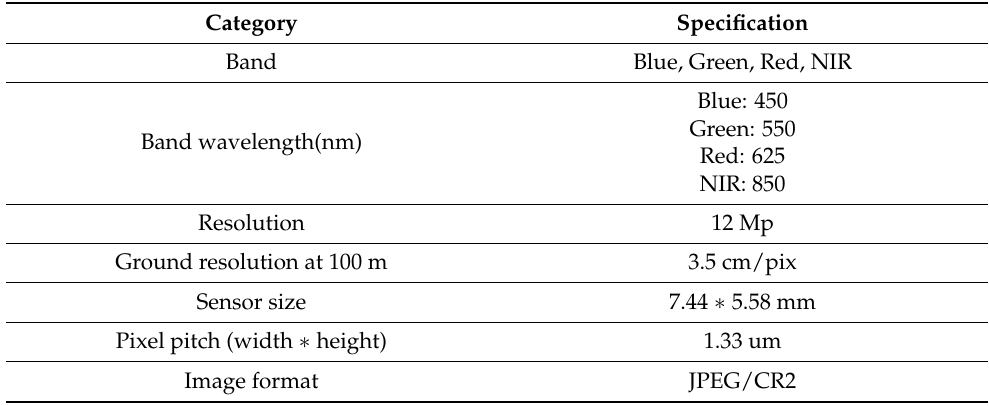
Table 1. Specifications of Canon S110 NIR camera.